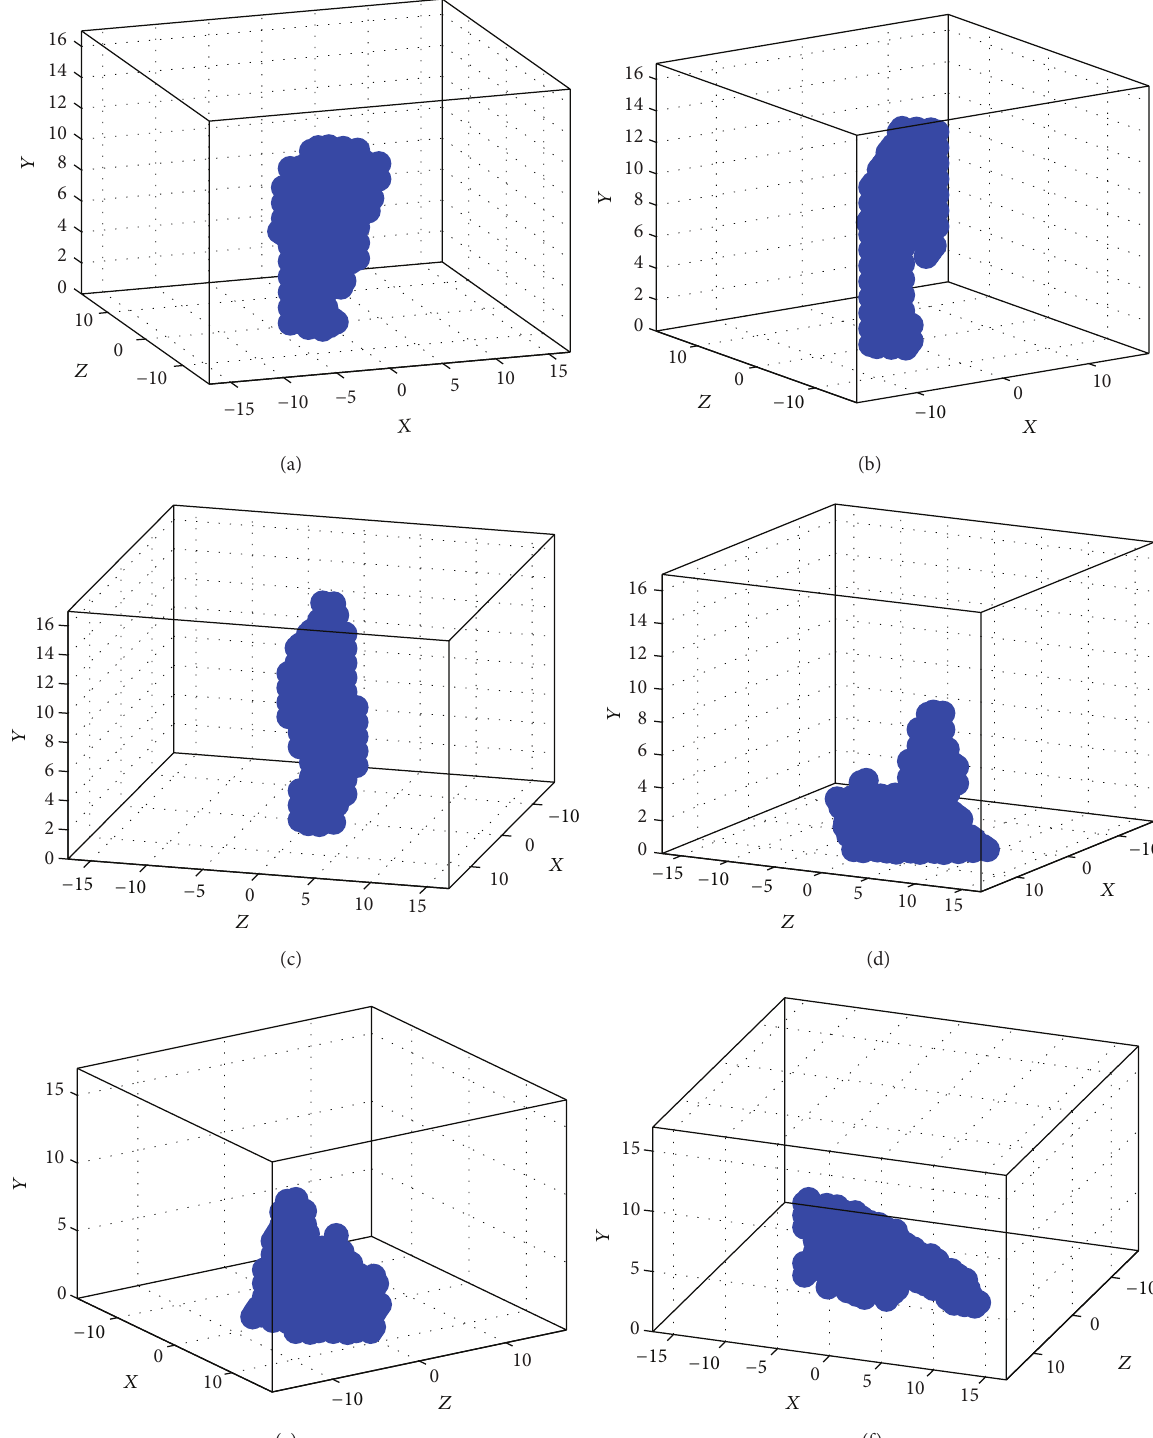
Figure 14: The constructed 3D voxel persons using the original images in Figures 12 and 13 and the SVI